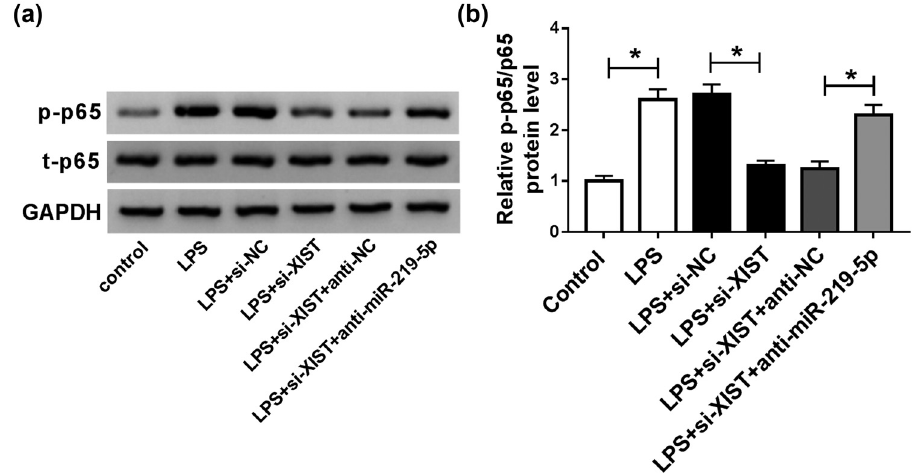
Figure 6: XIST silencing inactivated LPS - stimulated NF - κ B pathway by targeting miR - 219 - 5p. ( a and b ) BV2 cells were assigned to control, LPS, LPS + si - NC, LPS + si - XIST, LPS + si - XIST + anti - NC, and LPS + si - XIST + anti - miR - 219 - 5p groups, and then, the protein levels of p - p65 and t - p65 were measured by western blot assay. * P <